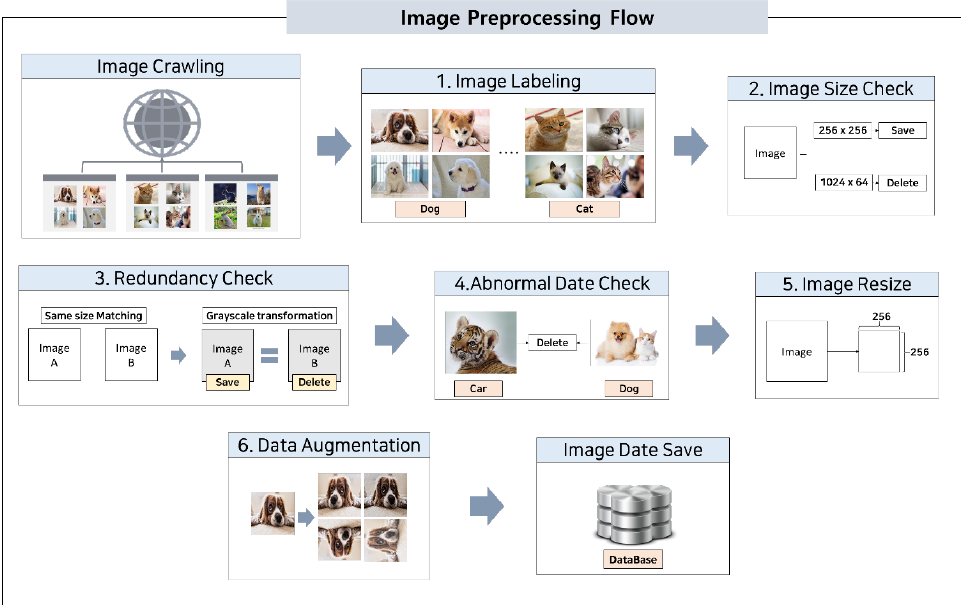
Figure 2. Flow chart of image data pre-processing